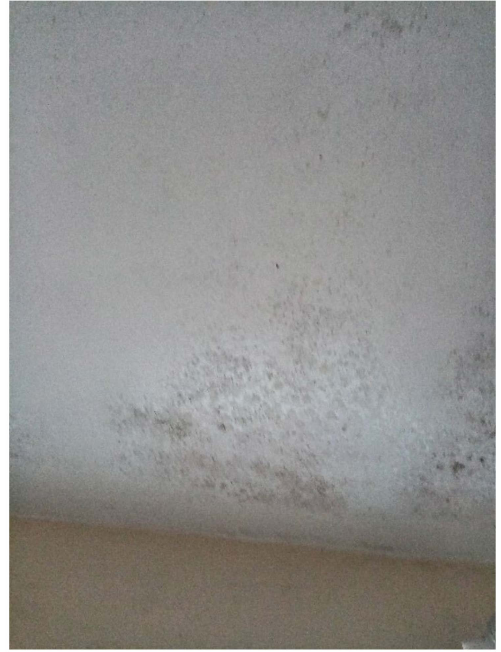
Figure 3. “Mould everywhere.”—Participant.Survey10.